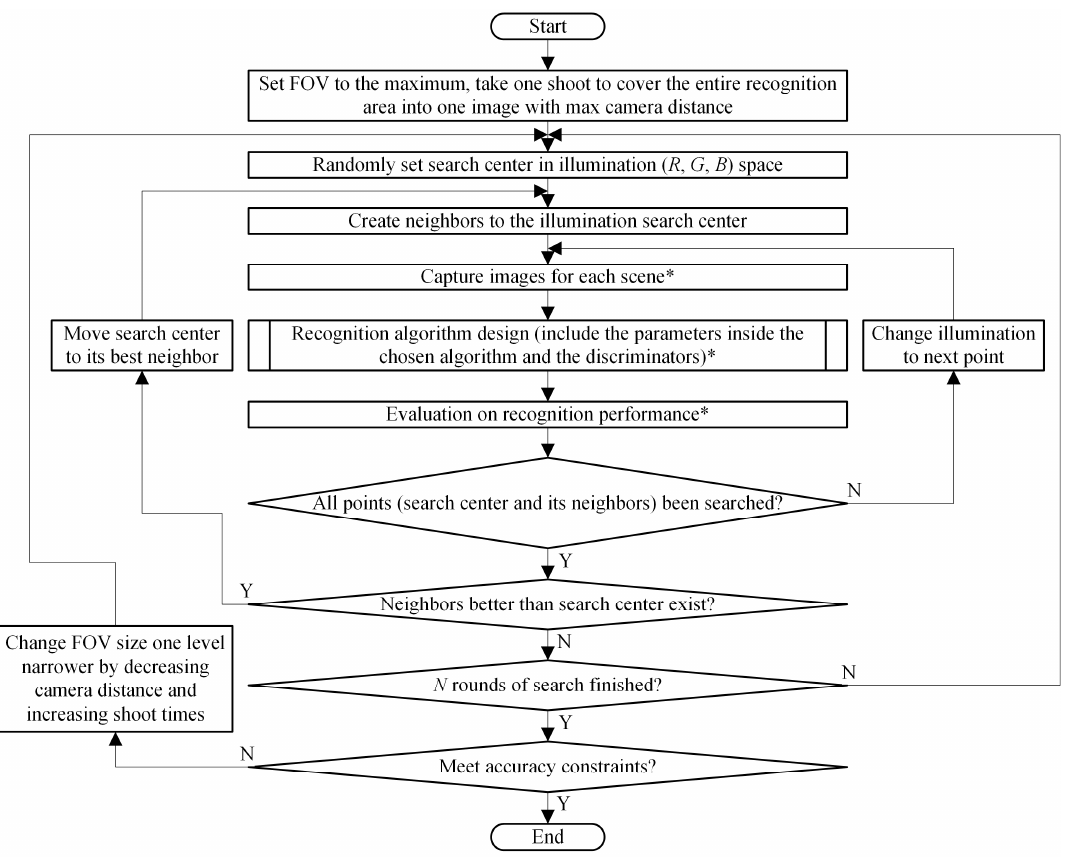
Figure 1. Proposed algorithm to design FOV, illumination and image pre-processing parameters for